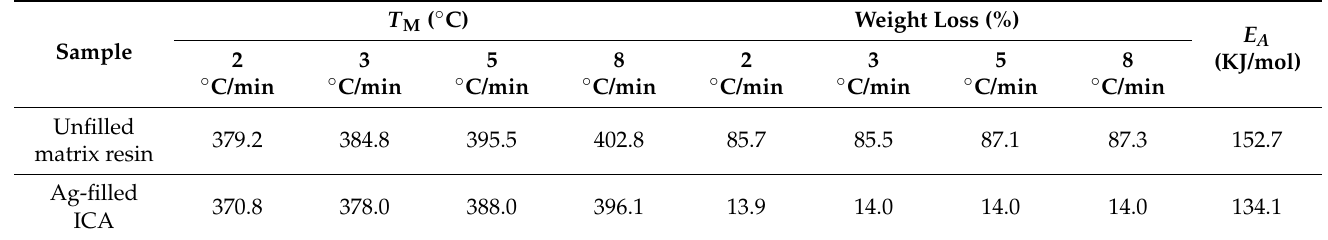
Figure 6. Thermogravimetric (TG) curves of the unfilled matrix resin ( a ) and their corresponding derivative thermogravimetric (DTG) curves ( b ); TG curves of the self-made ICA ( c ) and their corresponding DTG curves of the ICA ( d ). Table 5. Calculated decomposition kinetic parameters of the Ag-filled ICA and its unfilled matrix